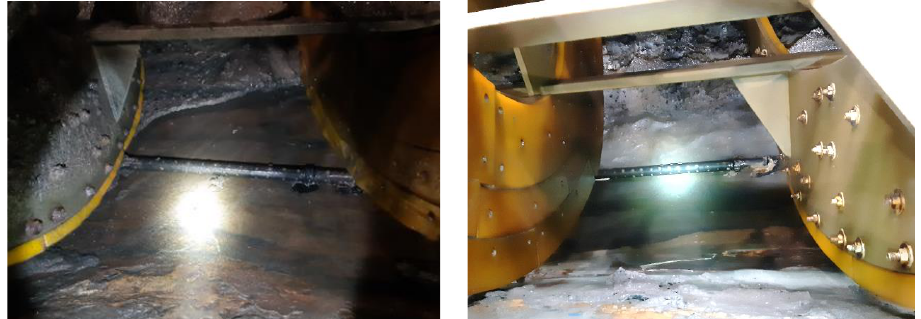
Figure 16. View of selected polarization anodes installed in a perforated ABS cover.